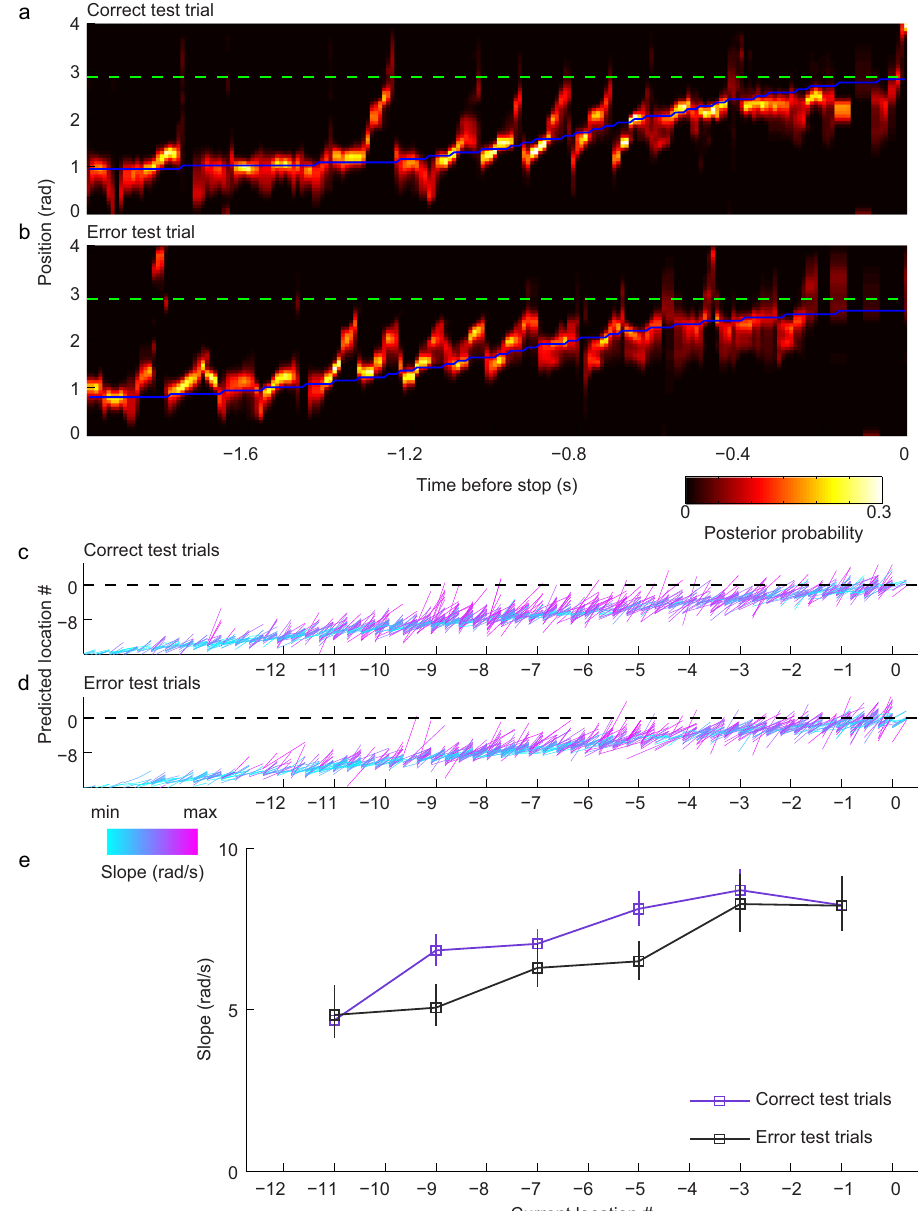
Fig. 3 Place cell sequences exhibited steeper slopes in correct test trials than in error test trials. a Example color-coded posterior probability distribution across time from a correct test trial. The green dashed line marks the correct goal location. The blue solid line represents the rat ’ s actual position at each time point. Trajectories were aligned according to the time when the animal stopped (time = 0). b Same as ( a ) but for an example error test trial in the same session. The rat stopped one location (~0.2 rad) earlier than the correct goal location in this trial (see Supplementary Fig. 2d for an example trial in which the rat stopped one location too late). c , d For purposes of illustration and comparison, place cell sequences in correct test trials ( c ) were randomly down-sampled to match the number of place cell sequences in error test trials ( d ). Fitted lines of detected place cell sequences in correct ( c ) and error ( d ) test trials are shown across location numbers as rats approached their stop location (indicated as location 0; same location as correct goal location for correct trials). The x and y coordinates of each sequence ’ s fi tted line indicate current position and predicted position (i.e., maximum posterior probability), respectively. The slope of the fi tted line for each sequence is shown color-coded. The black dashed line signi fi es stop location. Decoded locations within a sequence that extended beyond the stop location were included as part of that sequence, and locations in the sequence that extended beyond the stop location were included in the slope calculation. e Mean slopes of the lines that were fi t to detected place cell sequences are shown across current locations as rats approached their stop location (ANOVA, main effect of trial type (i.e., correct vs. error): F(1,2826) = 15.0, p = 1.1 × 10 − 4 , n = 1879 positive sequences detected from correct test trials and n = 959 positive sequences detected from error test trials). Slope measurements are plotted for the center of each location bin (i.e., locations − 12 to − 10 plotted at location − 11, locations − 10 to − 8 plotted at location − 9, etc.). Data are presented as mean ± error bars. Error bars indicate 95% bootstrapped con fi dence